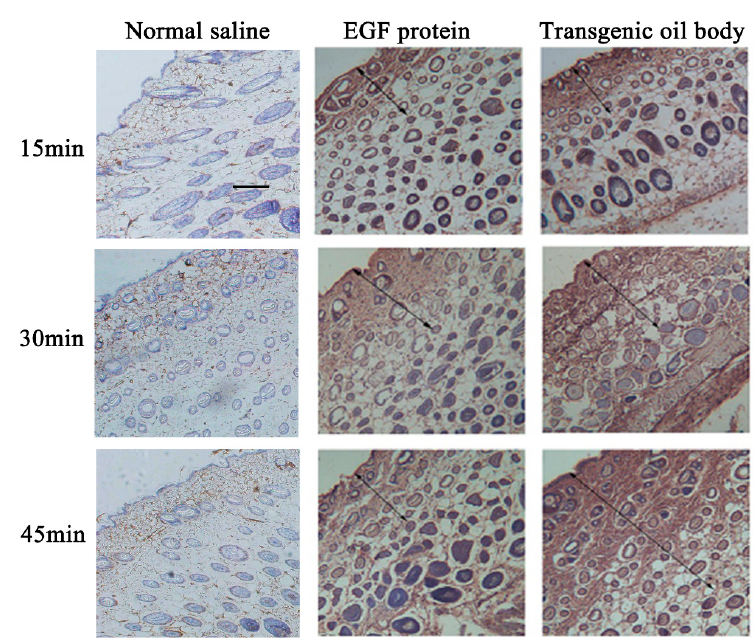
Figure 5. Ability of transgenic oil bodies bound hEGF to infiltrate into skin. The immunohistochemistry analysis of drug absorption at different times is shown. hEGF protein is the positive group and saline is the negative control group. Images shown at 40 × 10 magnification (scale bars = 50 µ m).